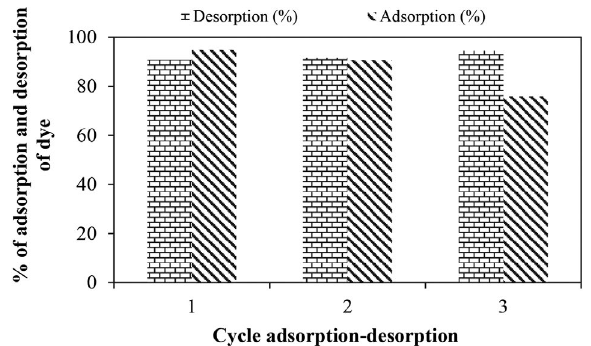
Fig. 15. Simultaneous adsorption-desorption cycles using